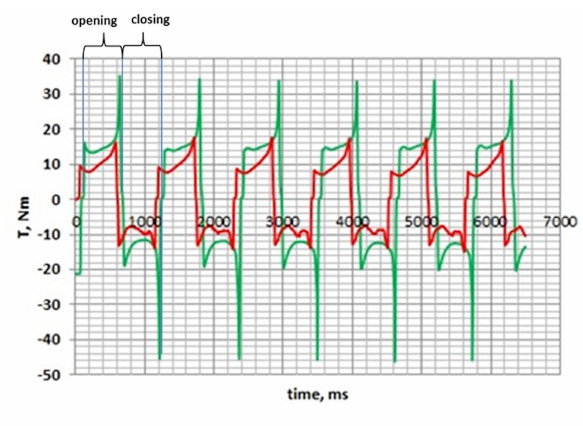
Figure 10: The course of the friction torque value in initial cycles (green) and final cycles (red) registered in valve sealed with variant 1